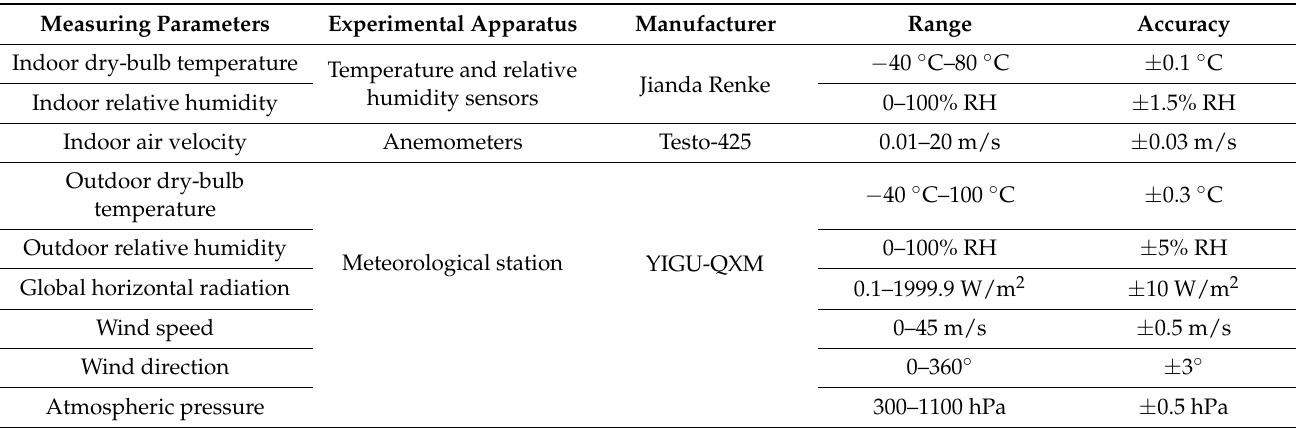
Table 3. Experimental apparatus with measuring range and